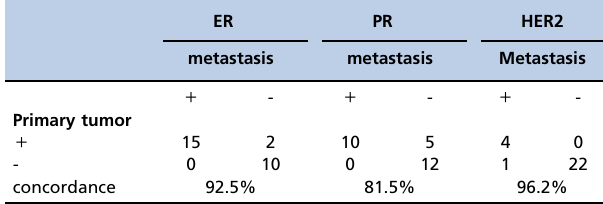
Table 2 - Estrogen receptor (ER), progesterone receptor (PR), and HER2 receptor expression patterns in primary tumors and metastases.